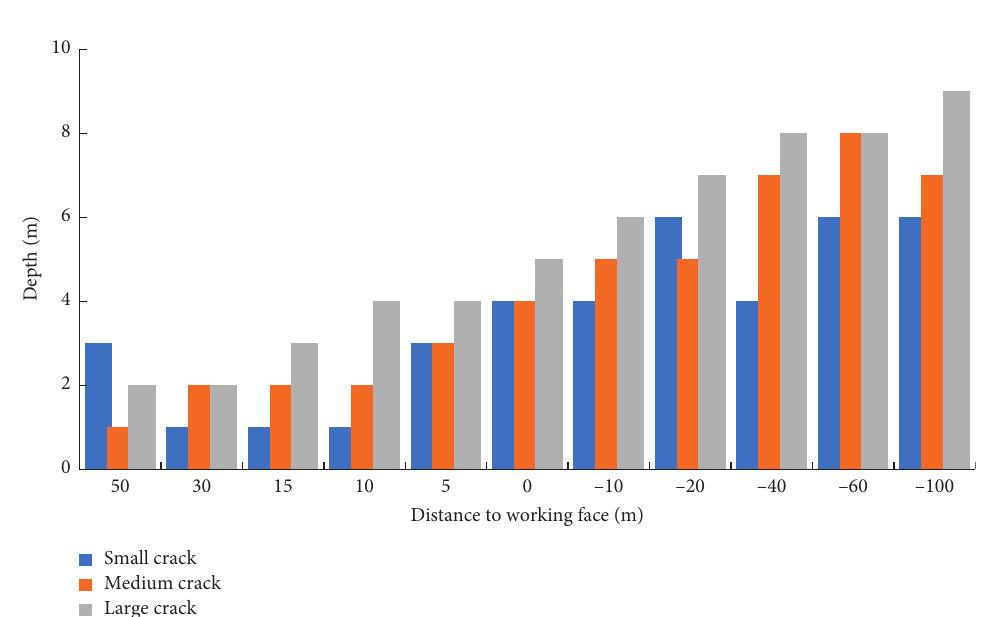
Figure 4: Statistical graph of cracks development in boreholes around working